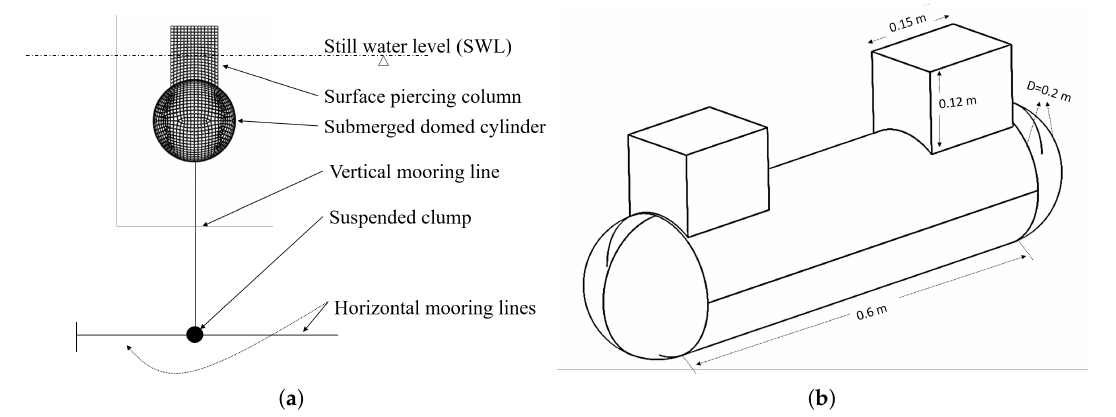
Figure 1. Geometry of the doomed cylinder body—( a ) schematic of the mooring setup and ( b ) perspective outline view of the submerged surface of geometry with dimensions; here, D is the diameter, and the overall length of the cylindrical body is 0.8